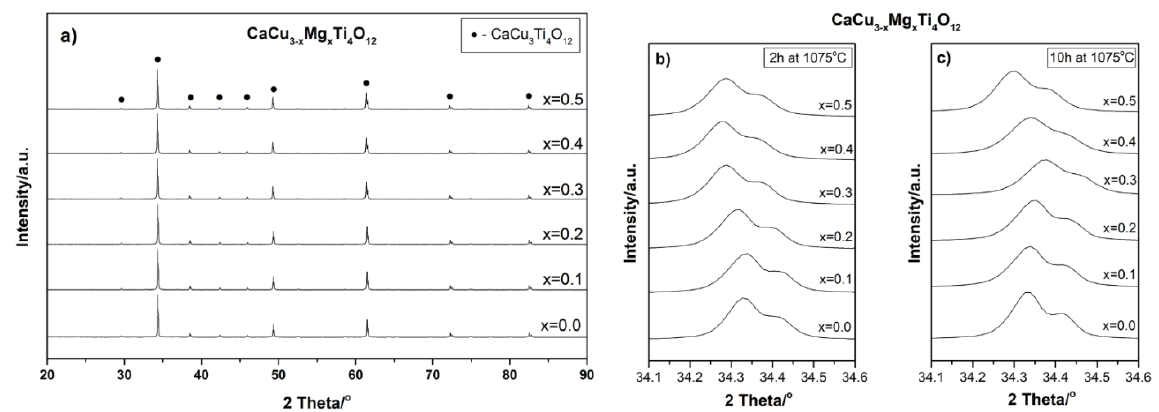
Figure 5 . XRD diffraction patterns of ( a ) the mechanochemically-prepared CaCu 3−x Mg x Ti 4 O 12 solid Figure 5. XRD diffraction patterns of ( a ) the mechanochemically-prepared CaCu 3 − x Mg x Ti 4 O 12 solid solutions with solutions with 0.1 ≤ x ≤ 0.5, subjected to subsequent heat treatment for 2 h at 1075 °C; zoom of the 0.1 ≤ x ≤ 0.5, subjected to subsequent heat treatment for 2 h at 1075 ◦ C; zoom of the 220 peak for materials subjected to subsequent heat treatment for: ( b ) 2 h at 1075 ◦ C and ( c ) 10 h at 1075 ◦